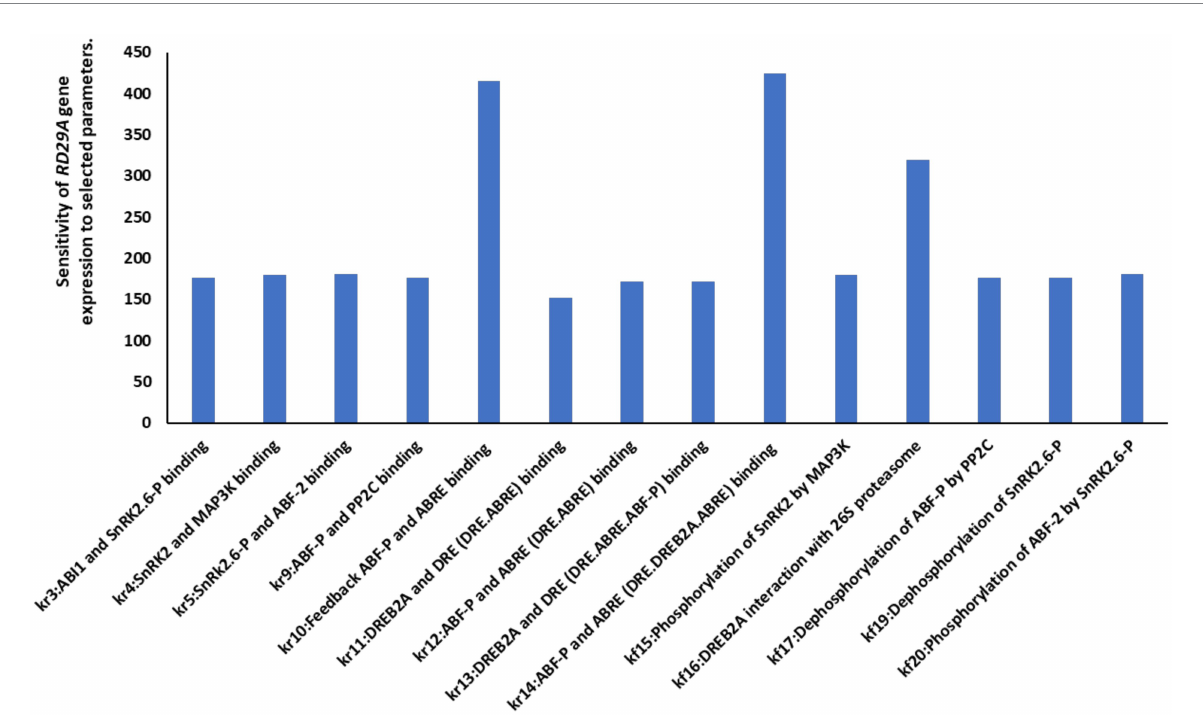
FIGURE 5 Sensitivity analysis of different parameters on RD29A gene expression. A sensitivity analysis conducted against the variable RD29A gene determined that the parameters for ABF-P-ABRE binding are most sensitive to the kinetics of RD29A gene expression. The y-axis shows the level of influence of the respective parameter on the output or RD29A gene expression. The higher the value, the higher the effect of the parameter on the gene